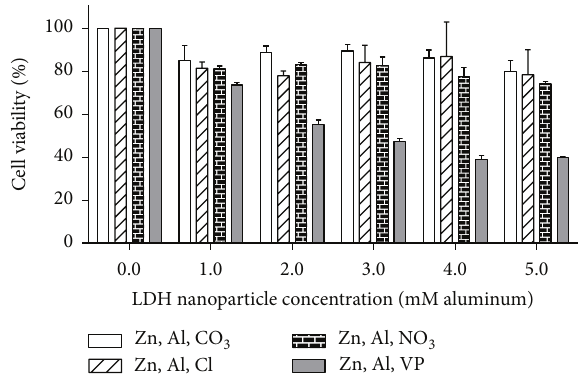
Figure 8: The effect of (Zn, Al)-LDH nanoparticles intercalated with valproate (Zn, Al, VP) on the viability of cultured pancreatic cancer BXPC3 cells. The effect of nanoparticles without the drug was assessed by using (Zn, Al)-LDH nanoparticles intercalated with either carbonate (Zn, Al, CO 3 ), chloride (Zn, Al, Cl), or nitrate (Zn, Al, NO 3 )